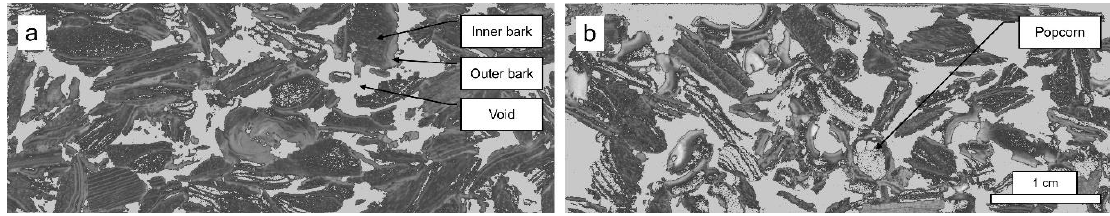
Figure 2. CT-tomograms, resolution 30 µ m; ( a ) larch bark insulation panel, 417 kg / m 3 , thickness 20 mm; ( b ) larch bark + popcorn (50 wt-%), 257 kg / m 3 , thickness 20 mm.